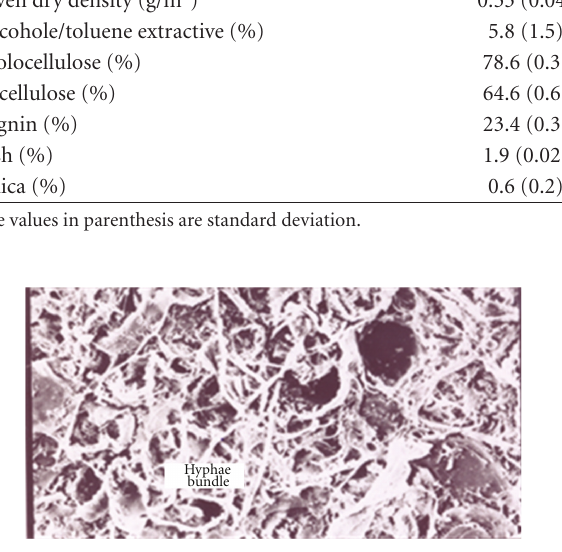
Figure 5: Brown rot hyphae bundle surrounding the vessel lumen (cross section, 600x).